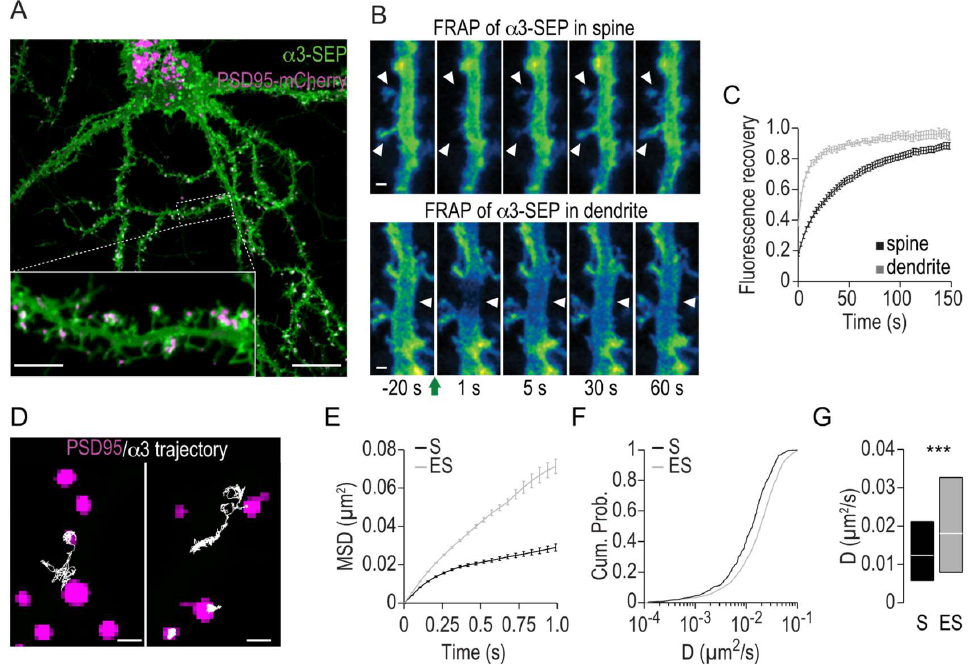
Figure 1. The Na,K-ATPase catalytic subunit α3 is highly mobile in hippocampal neurons. ( A ) Representative confocal picture of a hippocampal neuron (DIV24) transfected with α3 tagged with superecliptic pHluorin (SEP, green) and PSD95-mCherry (magenta). α3-SEP is expressed in dendritic segments and dendritic spines. Scale bars, 20 μm and 5μm in the inset. ( B , C ) Fluorescence recovery after photobleaching (FRAP) analysis of α3-SEP dynamics in dendritic segments and dendritic spines. ( B ) Time lapse images following photobleaching of α3-SEP in dendrites and spines. Images were pseudo-color-coded for SEP intensity. The green arrow indicates photobleaching, and white arrowheads indicate the regions that have undergone photobleaching. Scale bars represent 1 μm. ( C ) Mean ± standard error of the mean (SEM) of the normalized fluorescence intensity after photobleaching over time in dendritic segments (grey) and dendritic spines (black). ( D – G ) Lateral diffusion of α3 studied with SPT-QD. ( D ) Representative trajectories (white) of QD-bound α3-SEP in the membrane of hippocampal neurons and over PSD95-mCherry domains (magenta). Left, trajectories exchanging between synaptic and extrasynaptic regions; right, trajectories restricted to either extrasynaptic or synaptic regions. Scale bars represent 1 μm. ( E ) Mean ± SEM mean square displacement (MSD) plots for QD-bound α3-SEP in the extrasynaptic (ES, grey) and synaptic (S, black) regions. Cumulative probabilities ( F ) and median ±25–75% IQR ( G ) of the QD-bound α3 diffusion coefficient D in the extrasynaptic (ES, grey, n = 3678 trajectories) and synaptic (S, black, n = 610 trajectories) regions. *** p < 0.001 with the Mann–Whitney U test.